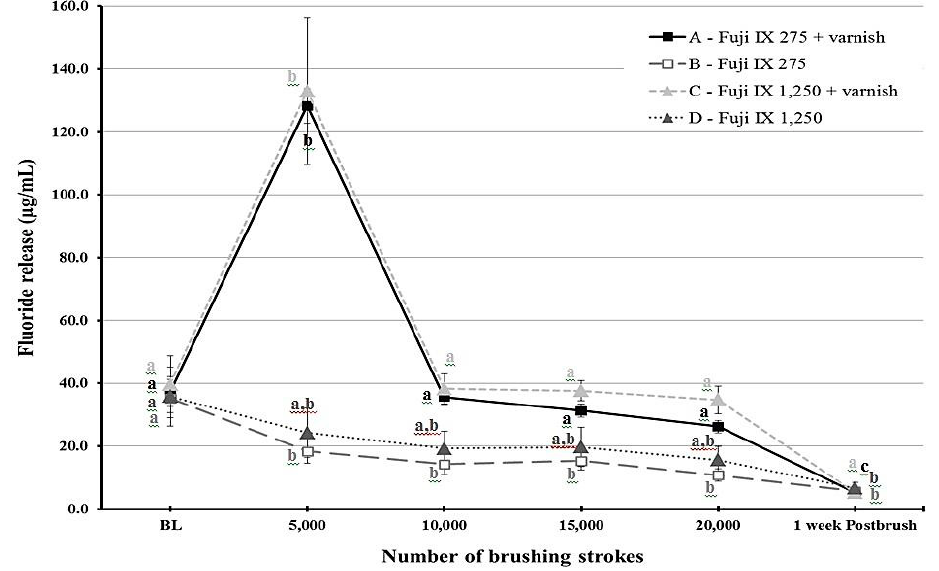
Figure 1. A line graph showing the mean fluoride release from Fuji IX (F9) material at different time points throughout the study period. Error bars indicate standard deviation. Same letters indicate non-significant differences ( p > 0.05) between values at different brushing levels within the same group.